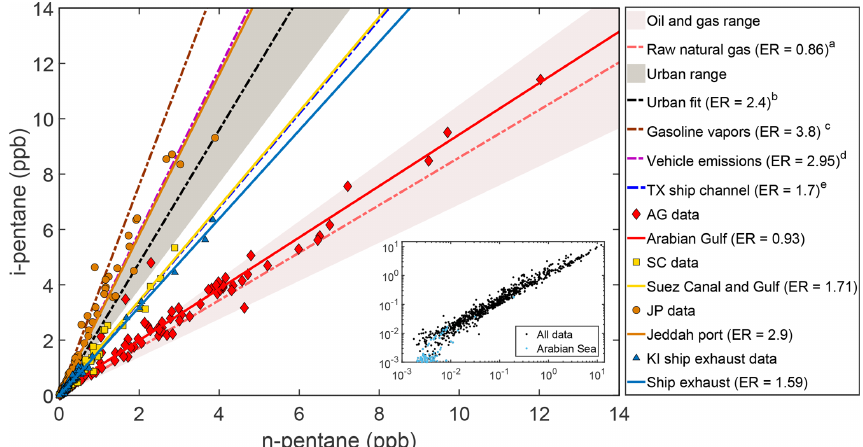
Figure 5. Relationship between pentane isomers. Linear fits of the data obtained in the Arabian Gulf, Suez Canal, and Jeddah port are compared to enhancement ratio slopes (ERs) from the literature with values for raw and natural gas ( a Gilman et al., 2013), urban areas ( b Baker et al., 2008), gasoline vapours ( c Gentner et al., 2009), vehicle emissions ( d Broderick and Marnane, 2002), and the Texas ship channel ( e Blake et al., 2014). Complete regression statistics: AG: 0 . 93 ×+ 0 . 13, R 2 = 0 . 97; SC: 1 . 71 ×− 0 . 02, R 2 = 0 . 98; JP: 2 . 9 ×+ 0 . 09, R 2 = 0 . 96; KI ship exhaust: 1 . 59 ×+ 0 . 01, R 2 = 0 . 99.